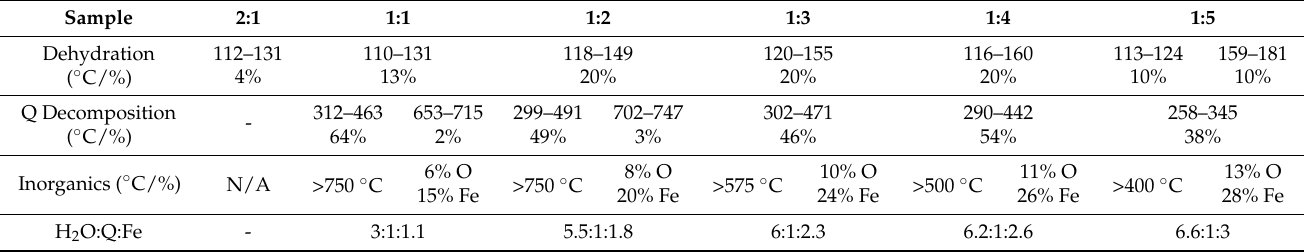
Table 1. TGA analysis of nanoparticles with different Q-Fe